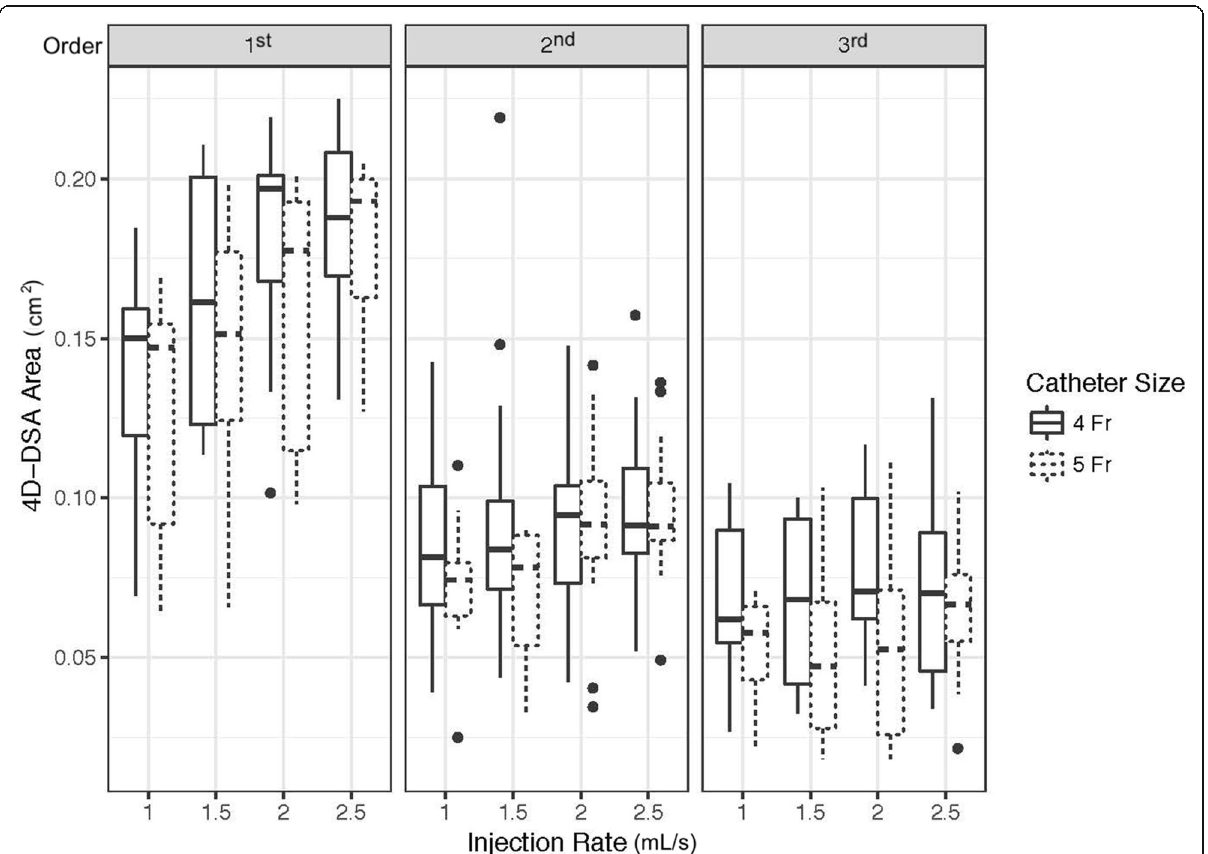
Fig. 4 Box-and-whisker plot of observed 4D-DSA area for 4-Fr and 5-Fr catheter sizes with different injection rates in the 1st, 2nd, and 3rd order hepatic arterial branches. Horizontal lines in the box represent median values. Higher injection rates yielded higher 4D-DSA areas and 4-Fr catheters led to a slightly higher 4D-DSA area across all